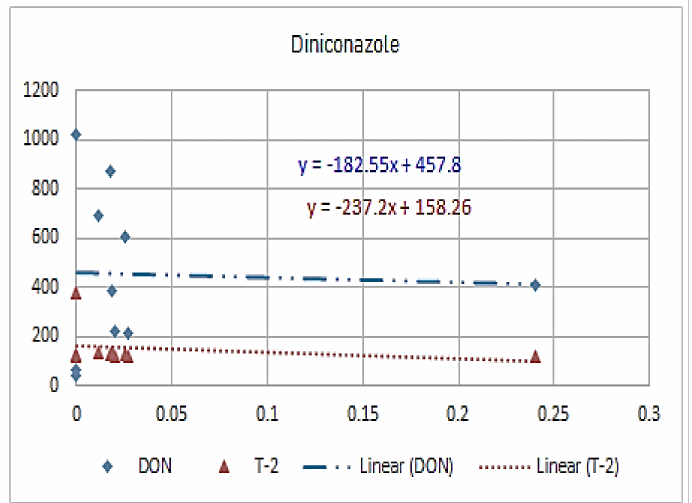
Figure 5. The relation between diniconazole residue (ppb) and DON and T-2 toxin (ppb) in wheat